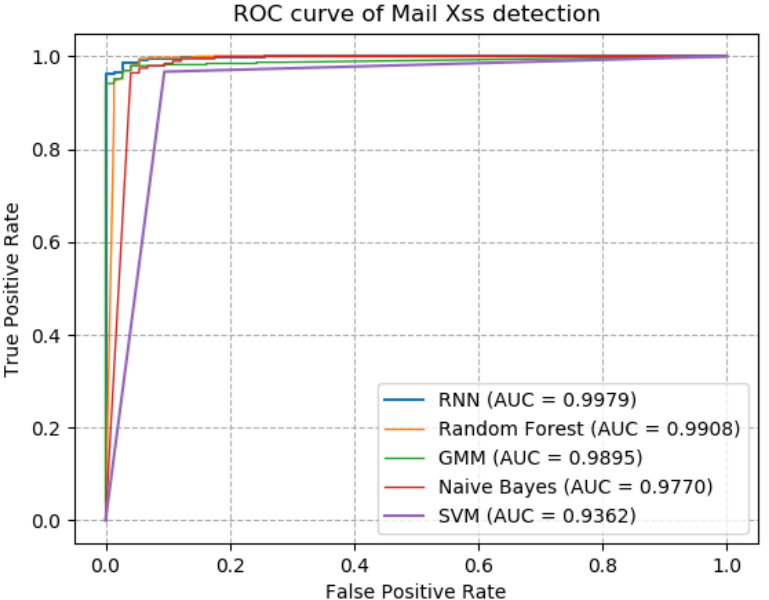
Figure 6. Bidirectional-Recurrent Neural Network (RNN) compared with traditional machine learning in ROC